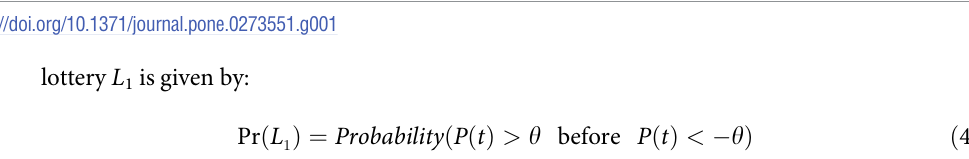
Fig 1. Sample trajectory of preference state in DFT. If the process reaches the upper boundary (resp. lower boundary) first, then lottery L 1 (resp. L 2 ) is chosen. Reproduced from